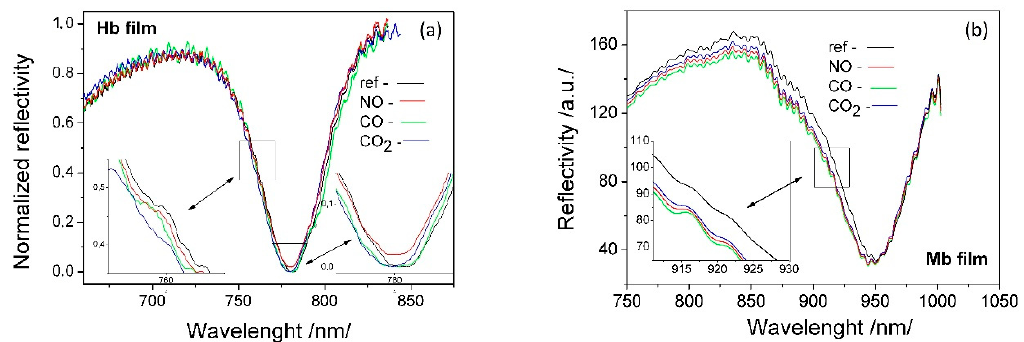
Figure 4. SPR resonance shift resulting from the binding of NO, CO and CO 2 to corresponding functional groups of: ( a ) Hb molecules; ( b ) Mb molecules.